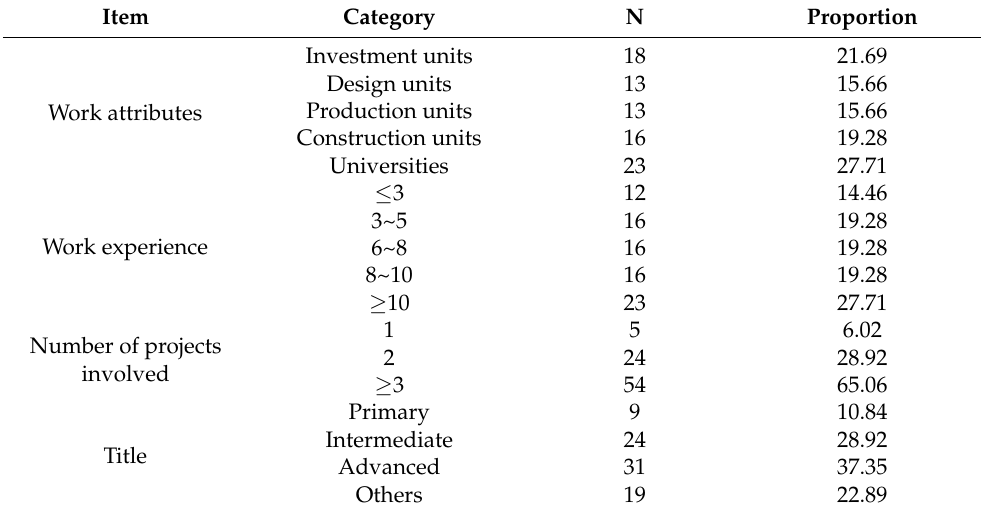
Table 4. Basic information of survey respondents.